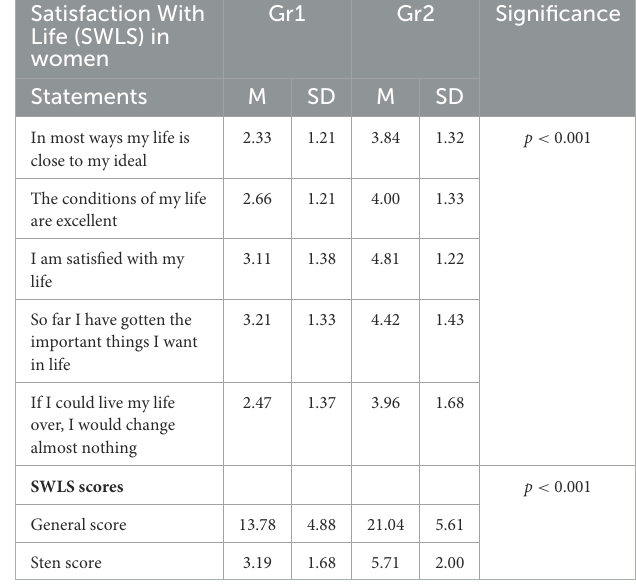
TABLE 4 Satisfaction With Life (SWLS) of women in Gr1 and Gr2.